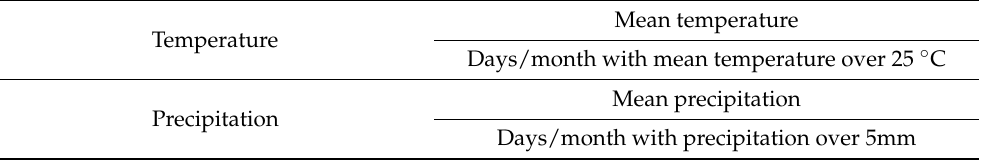
Table 1. Climate